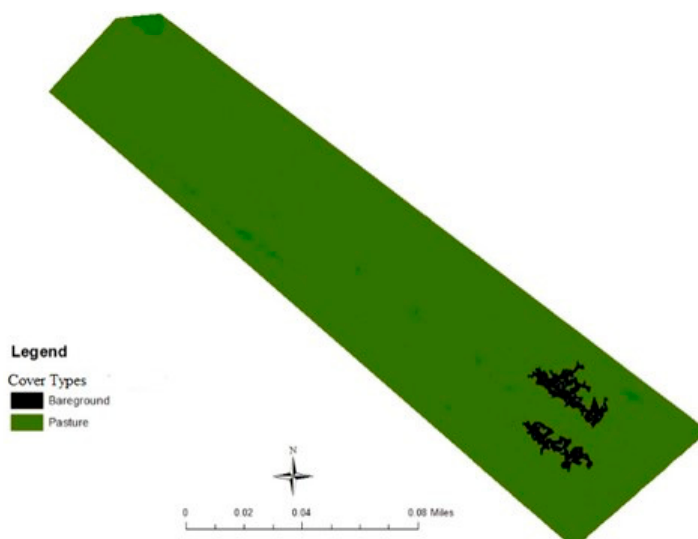
Figure 5. Post-flooding grazing land cover.